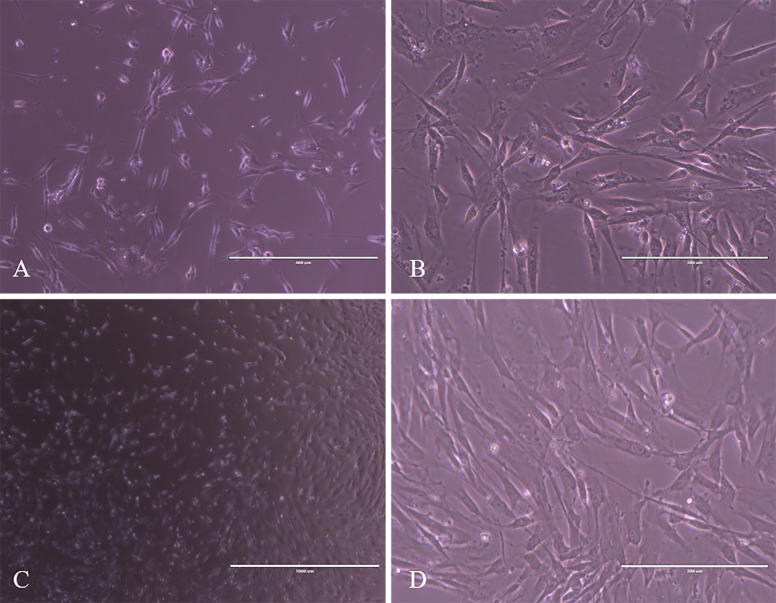
Photomicrographs of edited cells.A) cell at 24h in culture with fibroblastoid format. B) cells at 72 hours in culture note cell confluence. C) and D) observe the 80% of confluence after 6 days in culture 20X; 40X.